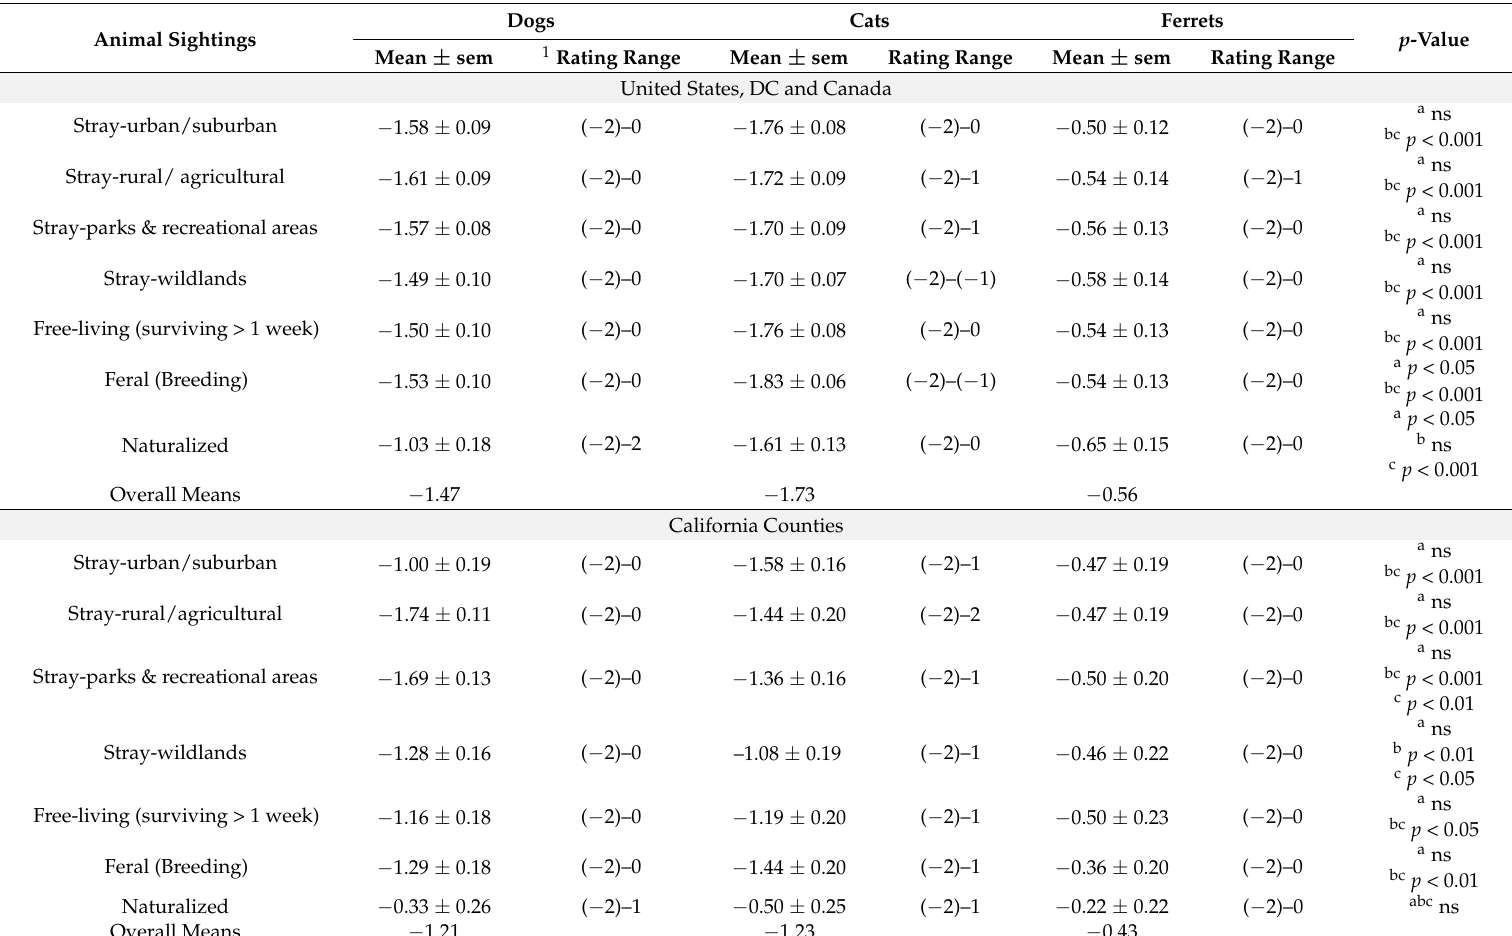
Table 2. “Degree of concern” regarding sightings of unconfined dogs, cats,